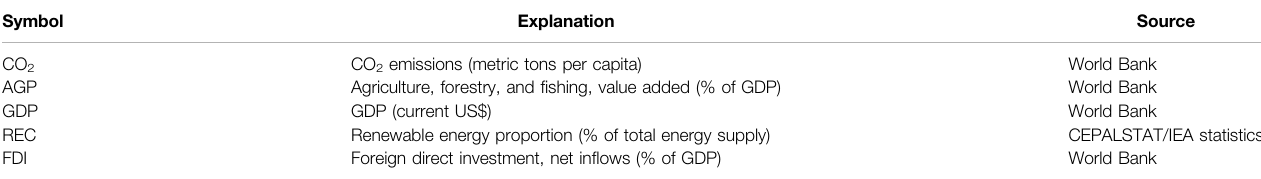
TABLE 1 | Descriptions of the variables used in the model.